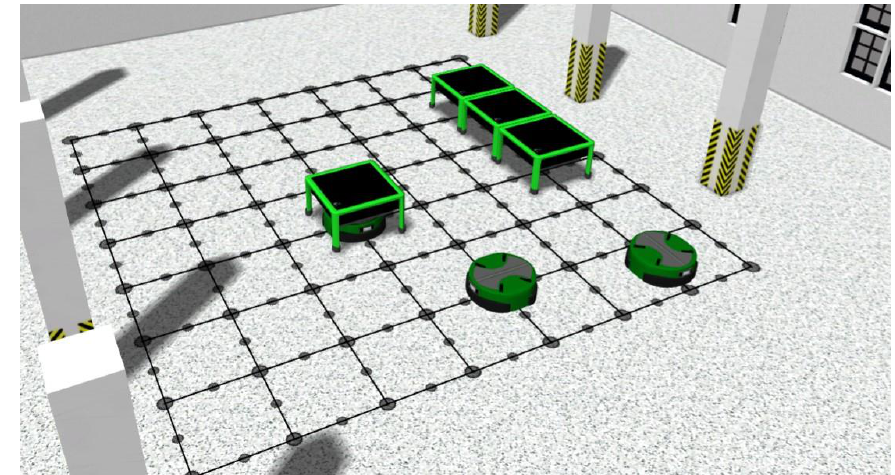
Figure 1. The modular platform (MP) carried by the mobile robotic system (MRS) and their virtual counterparts.